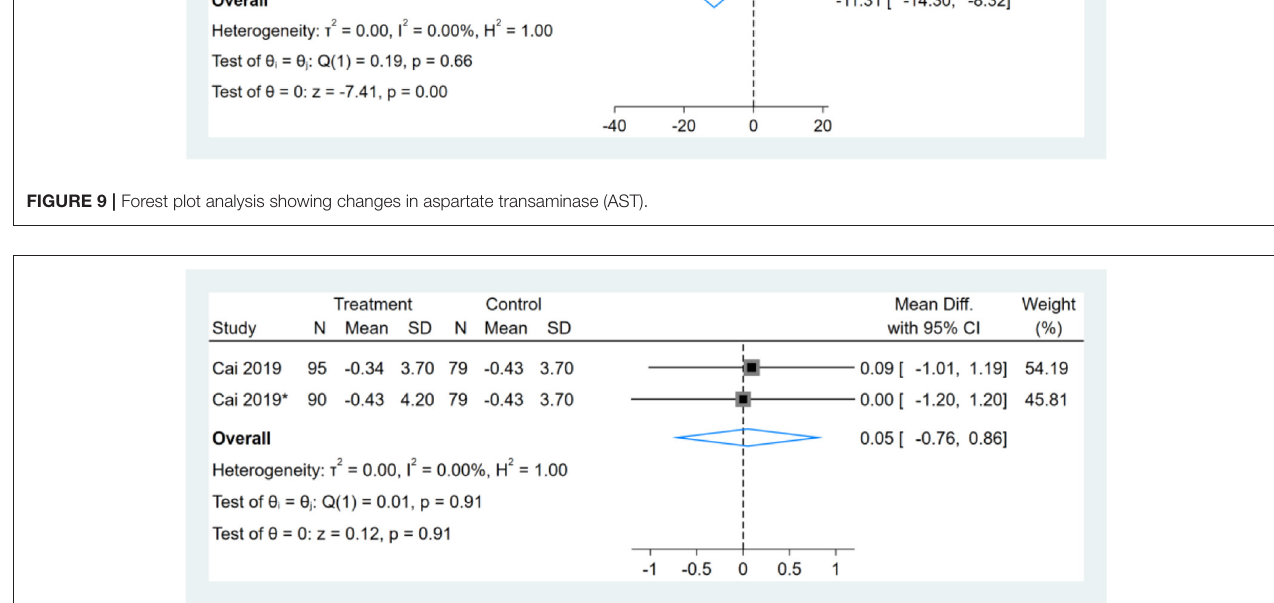
FIGURE 10 | Forest plot analysis showing changes in liver stiffness. *This study has two fasting intervention groups.